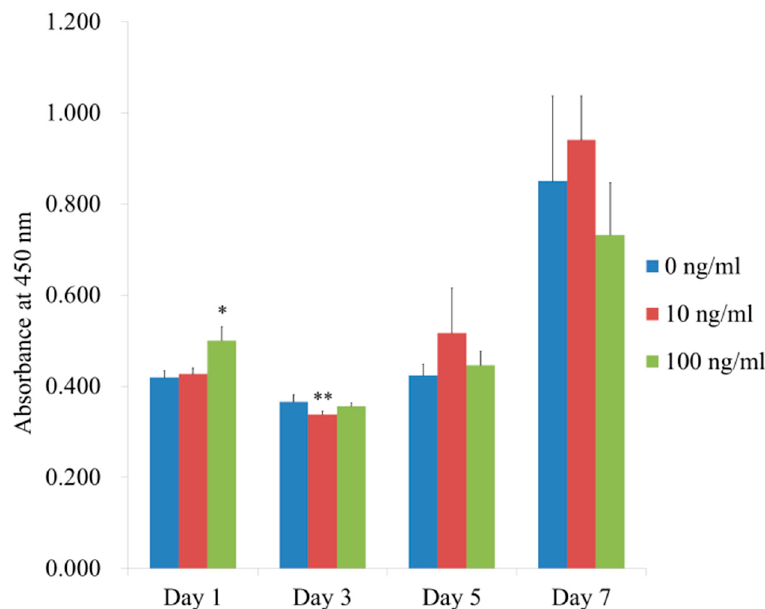
Figure 4. Cellular viability using Cell Counting Kit-8 on Days 1, 3, 5, and 7. * Significant differences were seen when compared to the control at Day 1 ( p < 0.05). ** Significant differences were identified when the value was compared to the control at Day 3 ( p < 0.05).